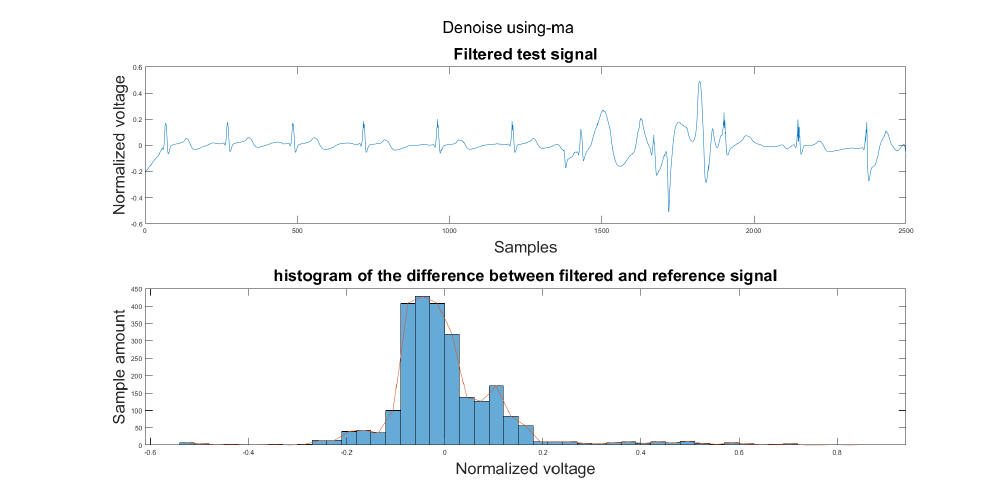
Figure A24. (1) Test signal, (2) histogram of the difference.